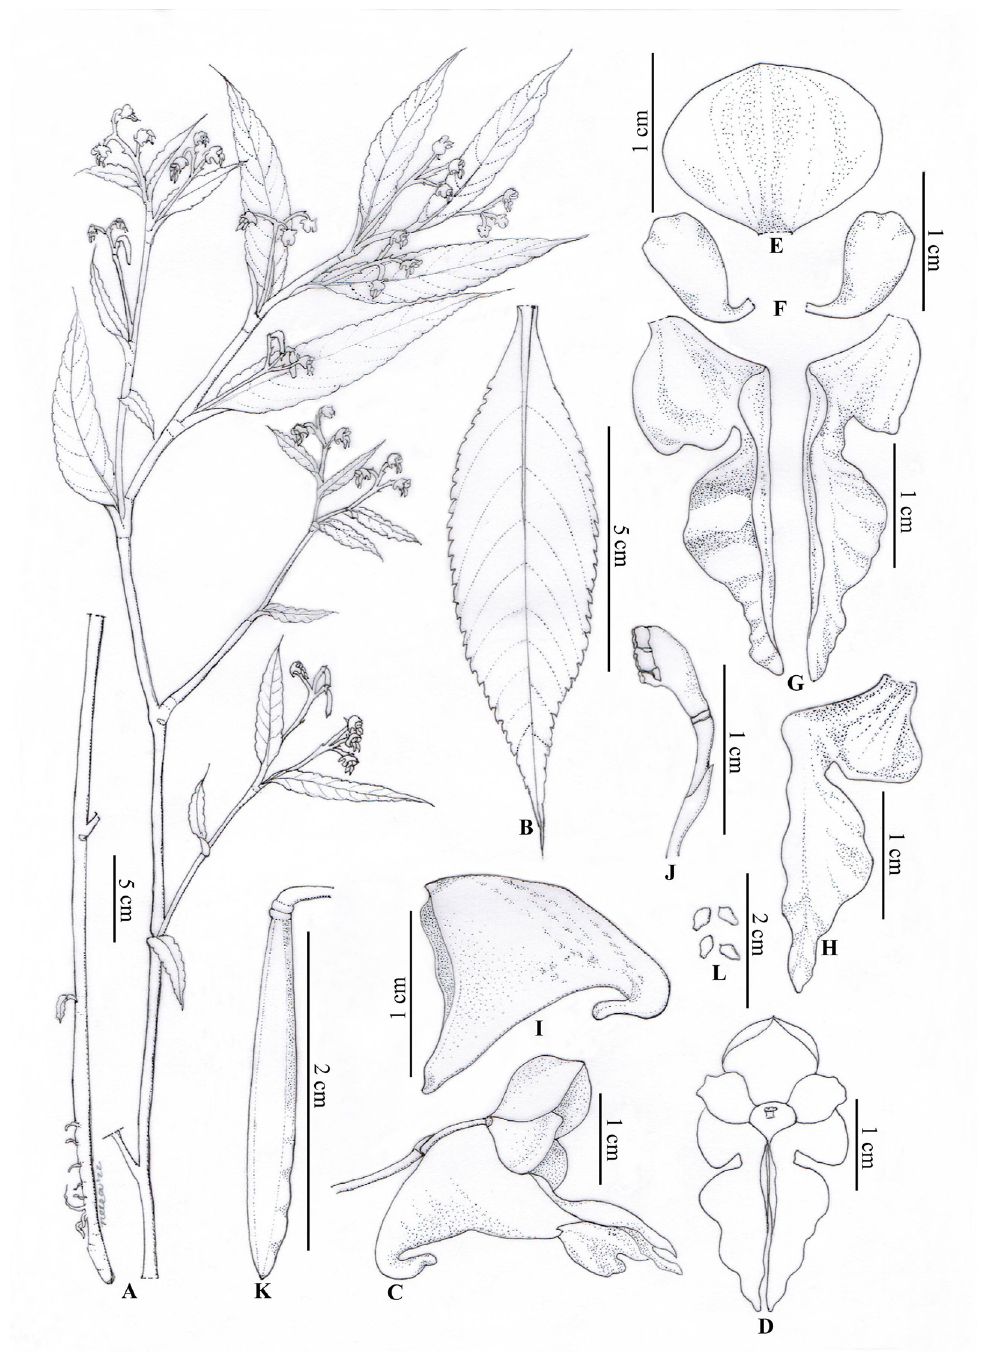
Fig 2. Line drawings of Impatiens nimspurjae : A. Flowering plant; B. Leaf; C. flower, side view; D. Flower (front view); E. Dorsal sepal; F. lateral sepals; G. Lateral united sepals (front view); H. Lateral united sepal (back view); I. Lower sepal; J. Ovary, pistil, pedicel and bract; K. Capsule; L. Seeds. Line drawings assisted by Neera Joshi Pradhan.